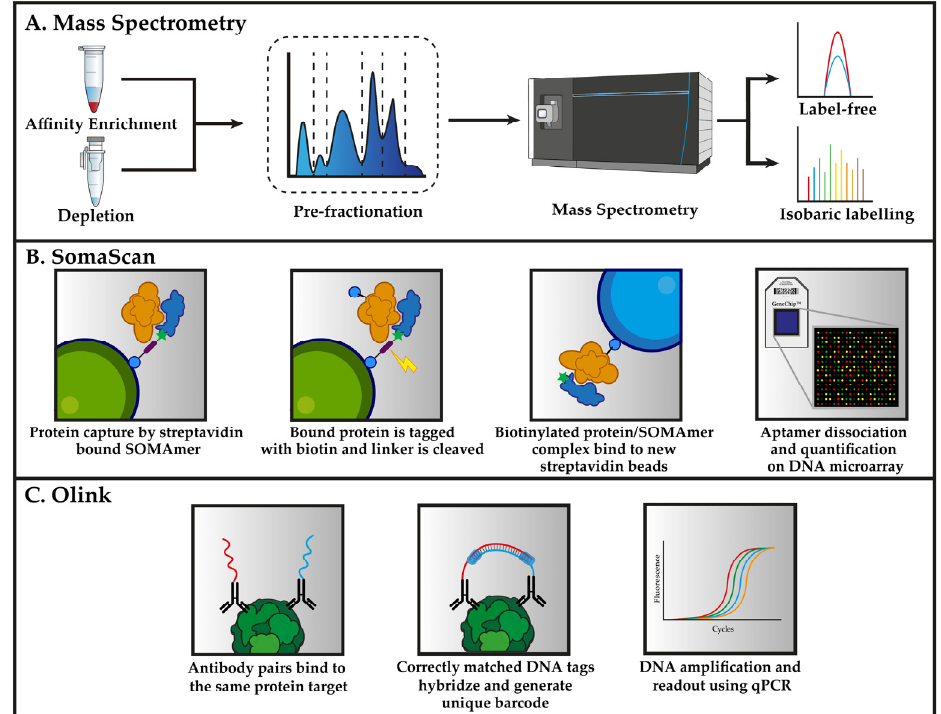
Figure 1. Workflows for the three primary analytical techniques that were deployed for proteomic analysis of plasma. ( A ) Mass spectrometry-based methods for the analysis of plasma typically relies on either depletion or enrichment to detect low-abundant proteins. Pre-fractionation prior to proteomic analysis is an optional step that separates the peptides in one dimension, thereby dividing the sample into a smaller fraction for later analysis. The quantification of proteins for explorative biomarker discovery is performed either label-free or using isobaric labelling reagents. ( B ) The SomaScan assay uses SOMAmers (blue) that are synthesized with a fluorophore, photocleavable linker as well as biotin, which is used to immobilize the SOMAmers to streptavidin beads. SOMAmer are able to capture proteins (orange) from solution followed by biotinylating of the captured proteins. The photocleavable linker is destroyed using external UV light to release the SOMAmer/protein complex back into the solution. Biotin-tagged proteins are recaptured on secondary streptavidin beads. SOMAmer dissociation is caused by denaturing of the captured protein, thereby allowing the SOMAmer reagents to hybridize to complementary sequences on a microarray chip. The abundance of each protein is derived from the amount of fluorescent intensity that is detected from each fluorophore. ( C ) Antibodies with the specificity for the same protein (green) are brought into close enough proximity that the attached DNA can hybridize and extend in the presence of a DNA polymerase. This process forms unique DNA barcodes for each protein in the assay, which can then be amplified and used for quantification using qPCR.